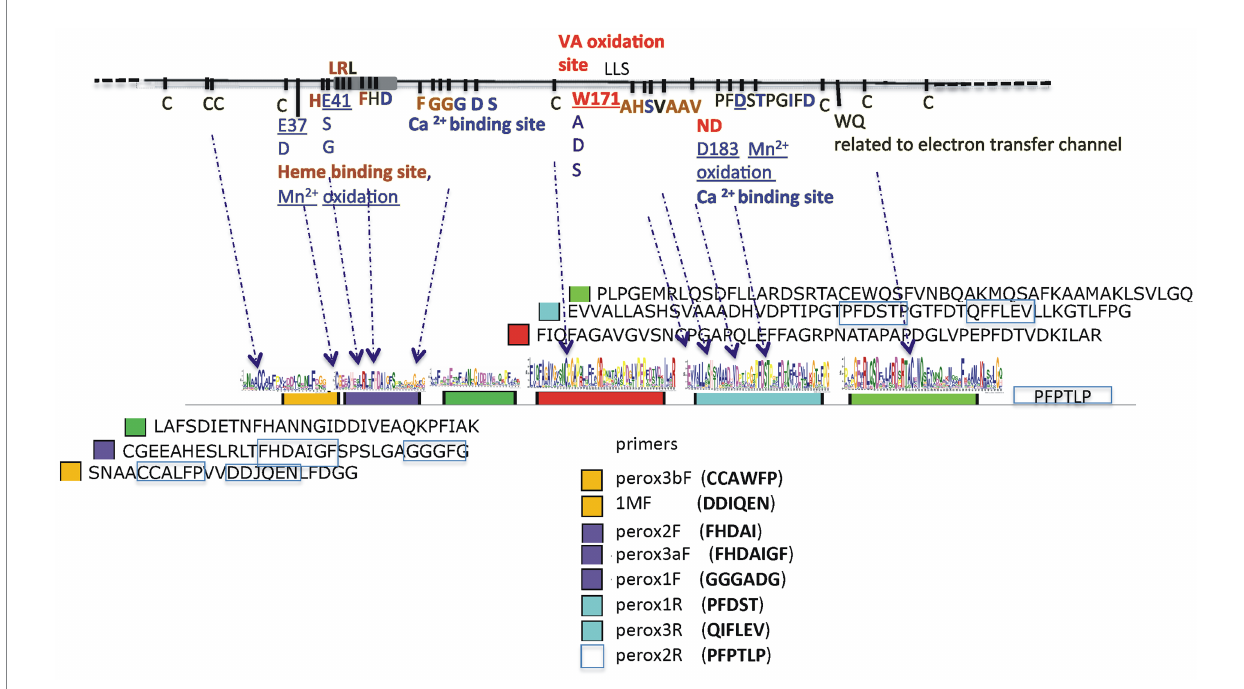
FIGURE 1 Α schematic presentation of the ancestral lignin peroxidase sequence with all amino acid residues important for the oxidization of substrates for heme Fe 3+ binding and to the Η 2 O 2 across channel, as well as for Ca 2+ binding and the formation of disulfide bonds (upper line). The six conserved regions are designated as colored closed boxes and arrows indicate their nucleotide sequences and relative positions ο n the ancestral sequence. The amino acid sequences of the conserved regions are shown at the right of each colored box and the conserved domains used for the construction of primers are boxed with blue